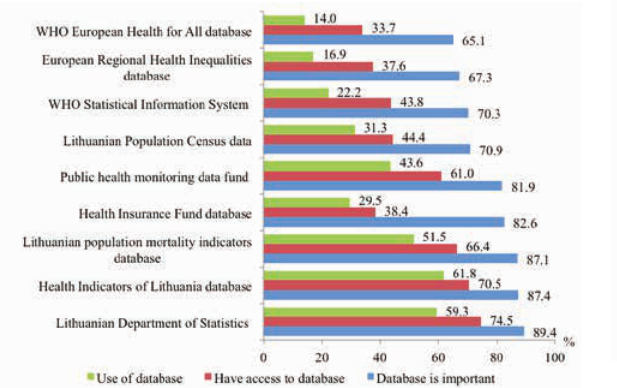
Figure 3: Respondents’ attitudes towards the usage of statistical databases for health inequality monitoring at their institutions